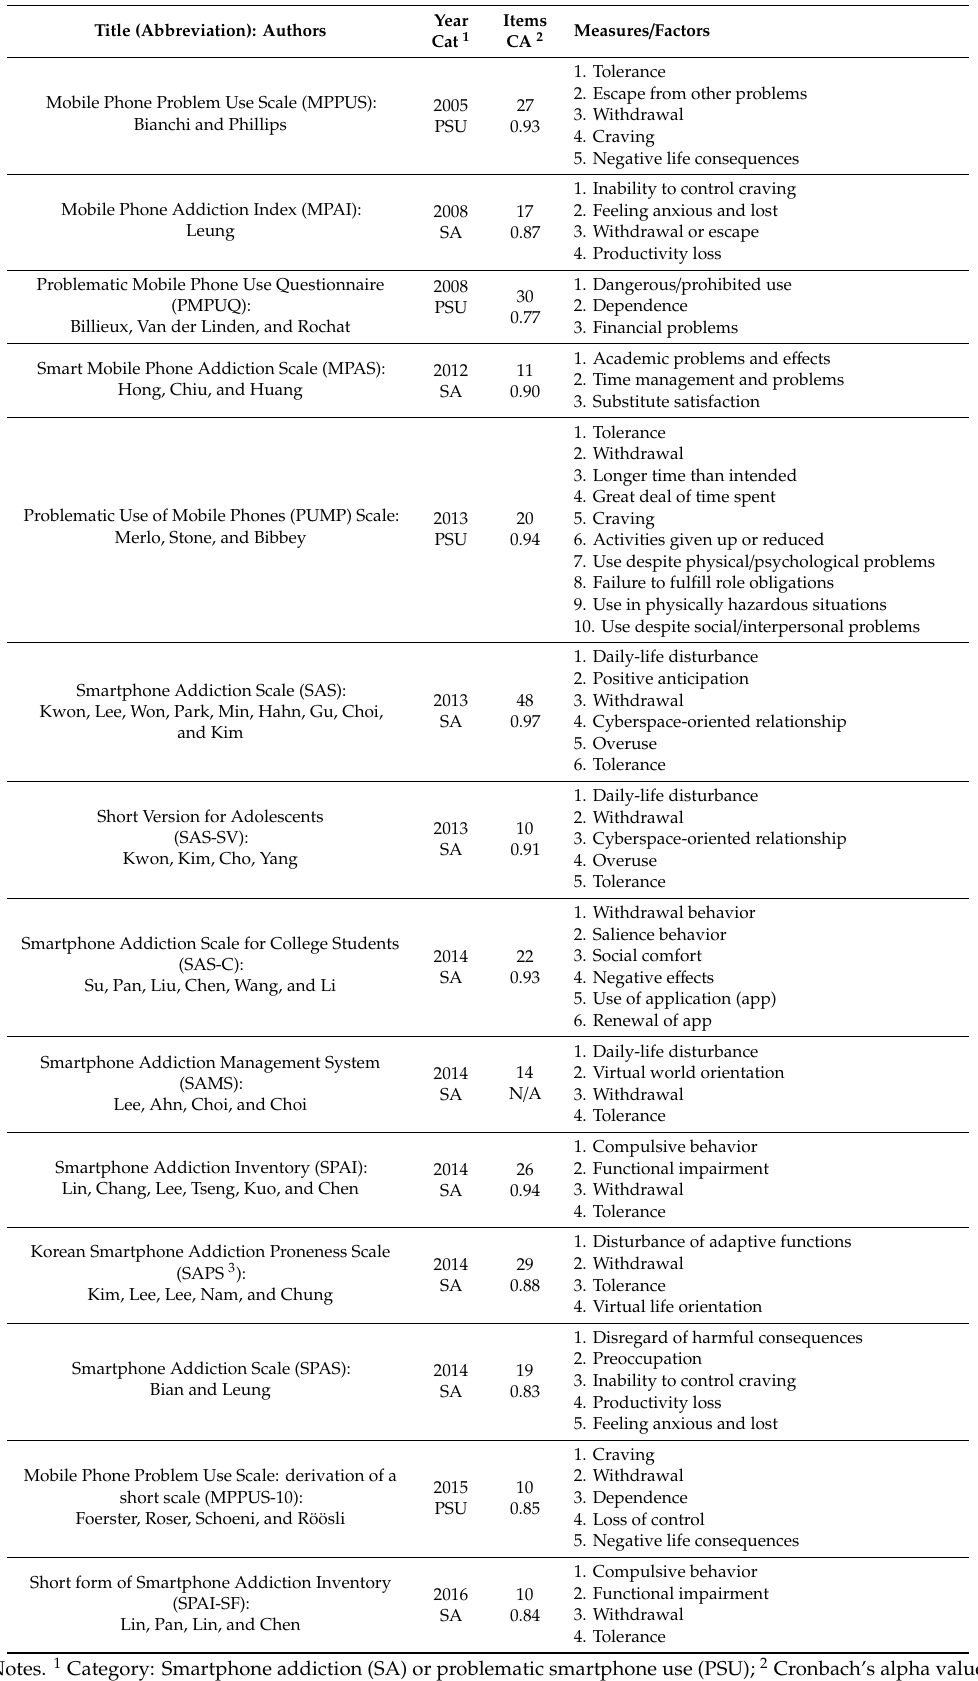
Table 1. Smartphone addiction / problematic smartphone use assessments in the literature. Title (Abbreviation):